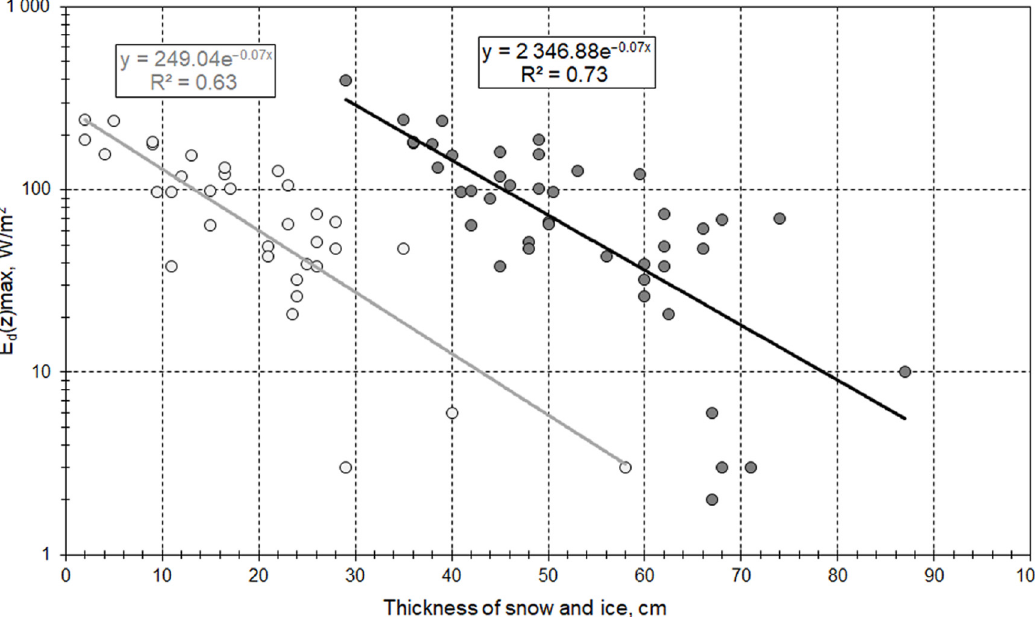
Figure 5. Solar radiation at the ice–water interface (daily maximum, E d (z)max) as a function of snow-ice cover thickness (dark grey circles), and thickness of snow, slush, and white ice (light grey circles) in spring in 1995–2000, 2002–2018, and 2020. Bold lines are the regression lines.